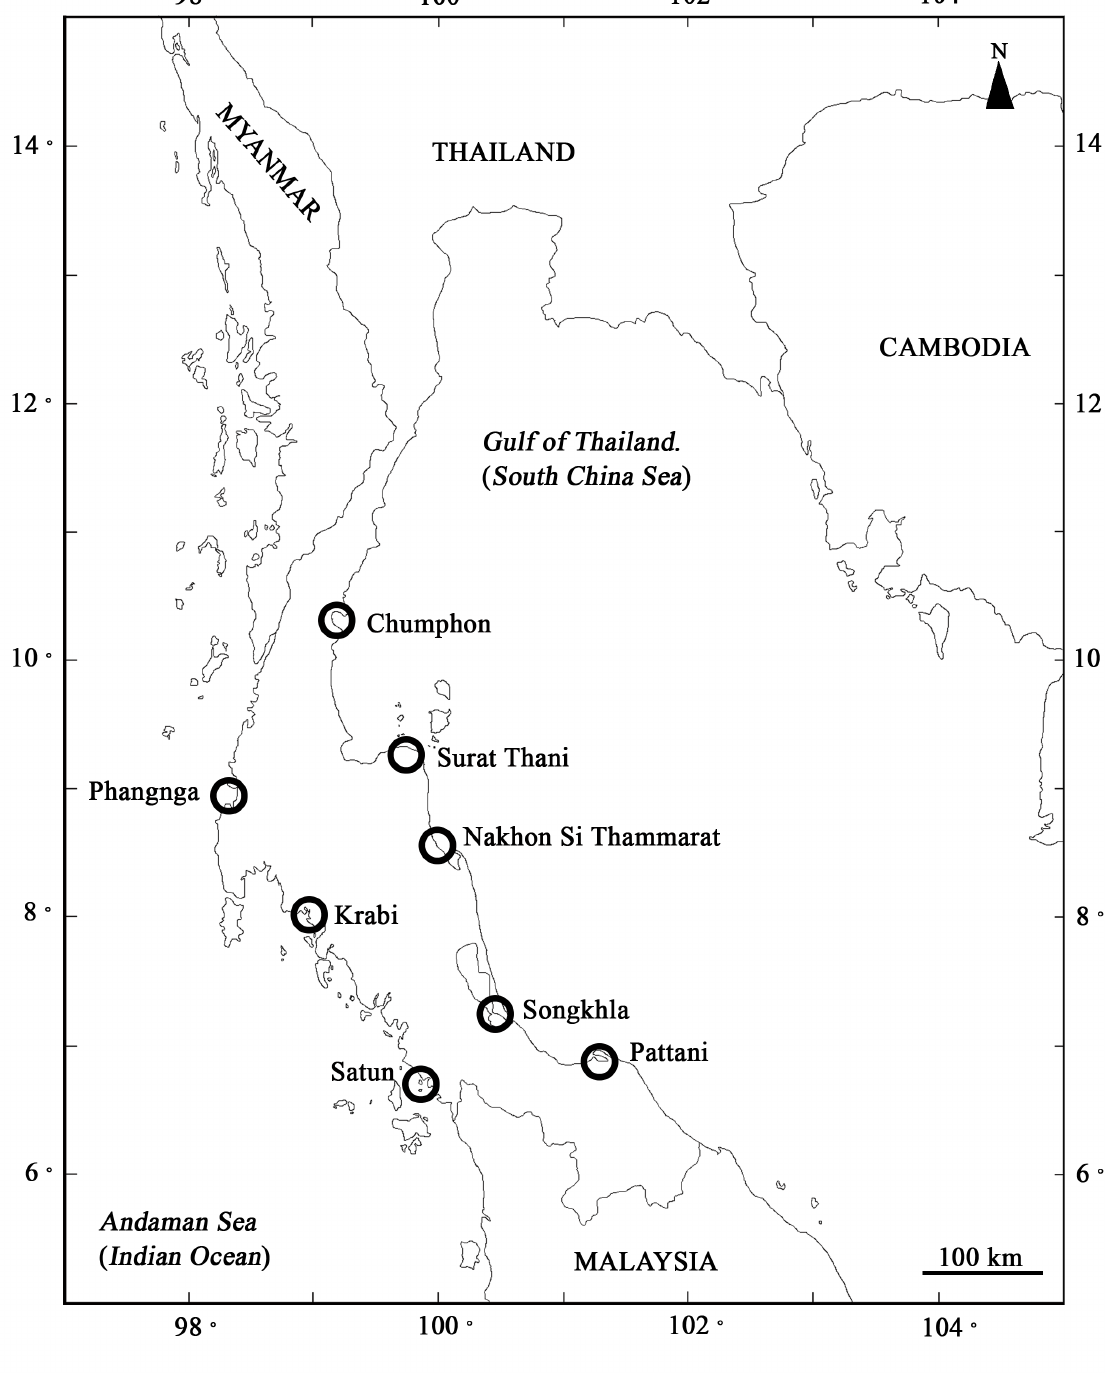
Fig. 41. Map of peninsular Thailand indicating the provinces respectively on the side of the Andaman Sea and the Gulf of Thailand (southern part of the South China